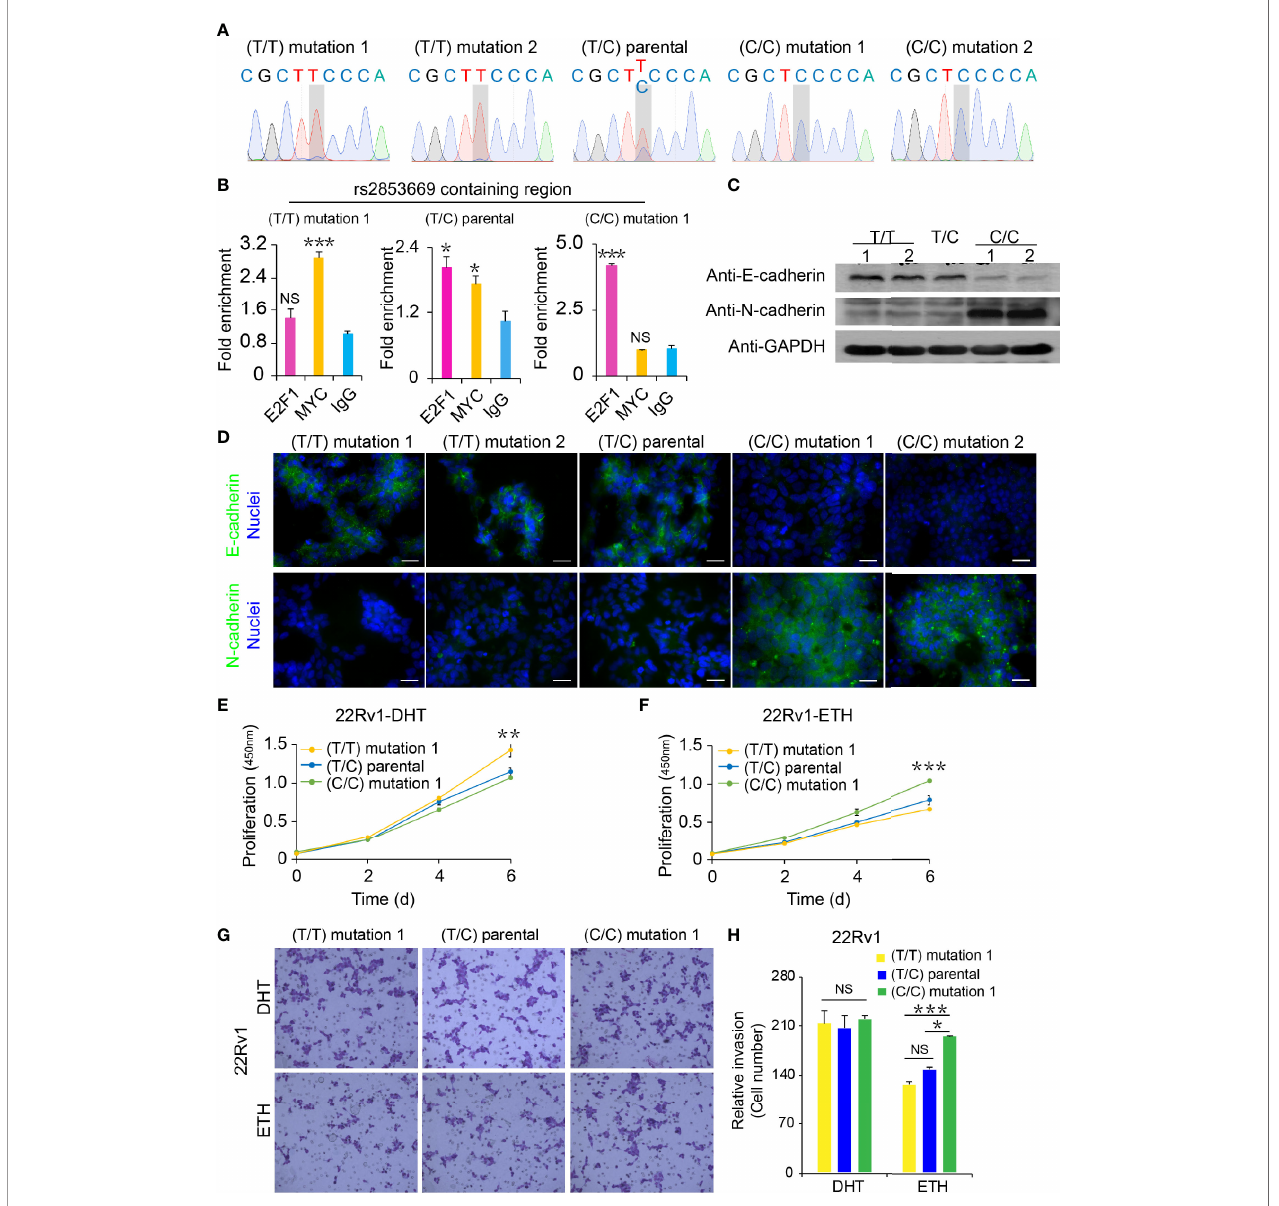
FIGURE 4 | Functional analysis of CRISPR/Cas9-modi fi ed PCa cells with different rs2853669 genotype. (A) Sanger sequencing of CRISPR/Cas9-modi fi ed and parental 22Rv1 cells. (B) Chromatin enrichment of E2F1 and MYC at the rs2853669 site measured by ChIP-qPCR. (C) Western blot showing the protein levels of E- cadherin and N-cadherin in CRISPR/Cas9-modi fi ed and parental 22Rv1 cell lines. GAPDH was used as a loading control. (D) Representative microscopy analysis of E-cadherin (green; upper panels) and N-cadherin (green; lower panels) expression in CRISPR/Cas9-modi fi ed and parental 22Rv1 cell lines. Nuclei were counterstained with DAPI (blue). Scale bars, 20 m m. (E, F) Cell proliferation analysis of the TT genotype, TC genotype, and CC genotype at rs2853669 in 22Rv1 cells under androgen stimulation (E) or withdrawal (F) , mean ± SD of triplicate experiments. (G, H) Representative images of invasion (G) assays for cells under androgen stimulation or withdrawal. Scale bars, 100 µm. The number of cells in invasion (H) assays. ± s.e.m. from three biological replicates, * p < 0.05, ** p < 0.01, *** p < 0.001, Student ’ s t test. NS, Non signi fi